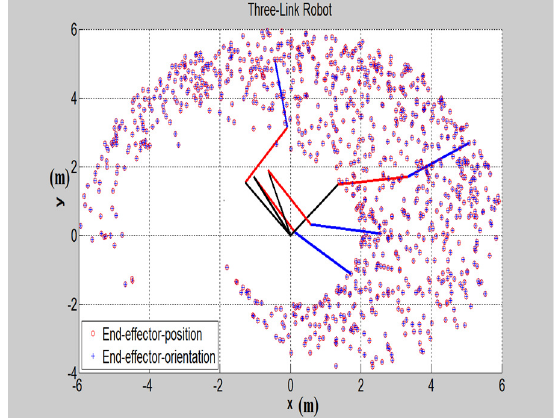
Fig. 3. BPNN structure for three-link robot of TH 1 output.